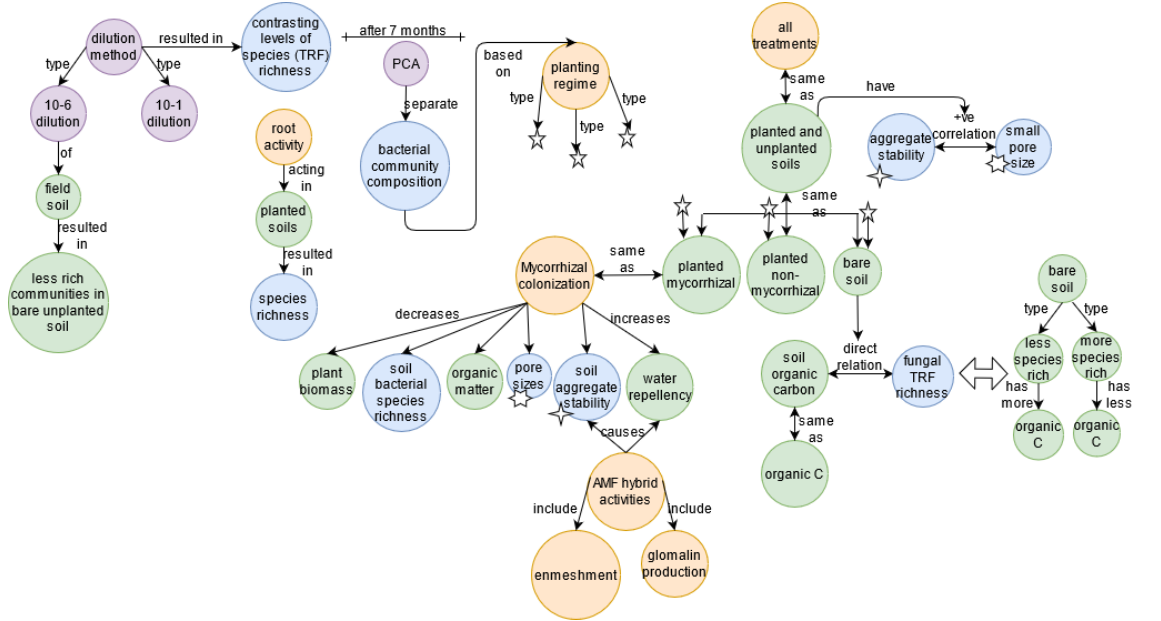
Figure A5. Structured KG representation of an Agriculture domain publication Abstract [69] as process, method, material, and data typed entities.